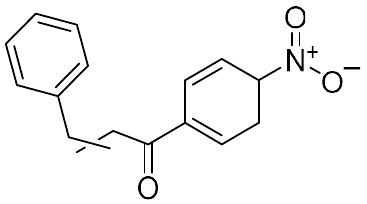
Figure 13. An active compound derived from piperidine present in Piper piressi .